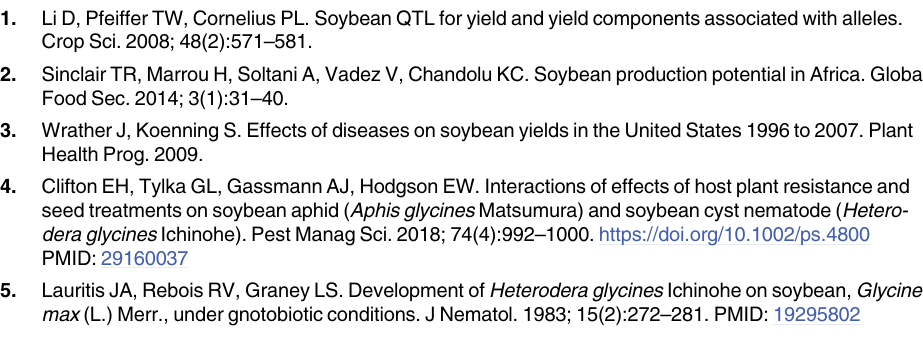
S2 Fig. Greenhouse experiment to phenotype tolerance of soybean to the infection of the soybean cyst nematode based on plant biomass. There were 480 16-cm-diam pots for 60 soy- bean lines each time of the experiment. S3 Fig. Kinship plot of 234 soybean genotypes. Values within heat map were obtained from the Kinship matrix of